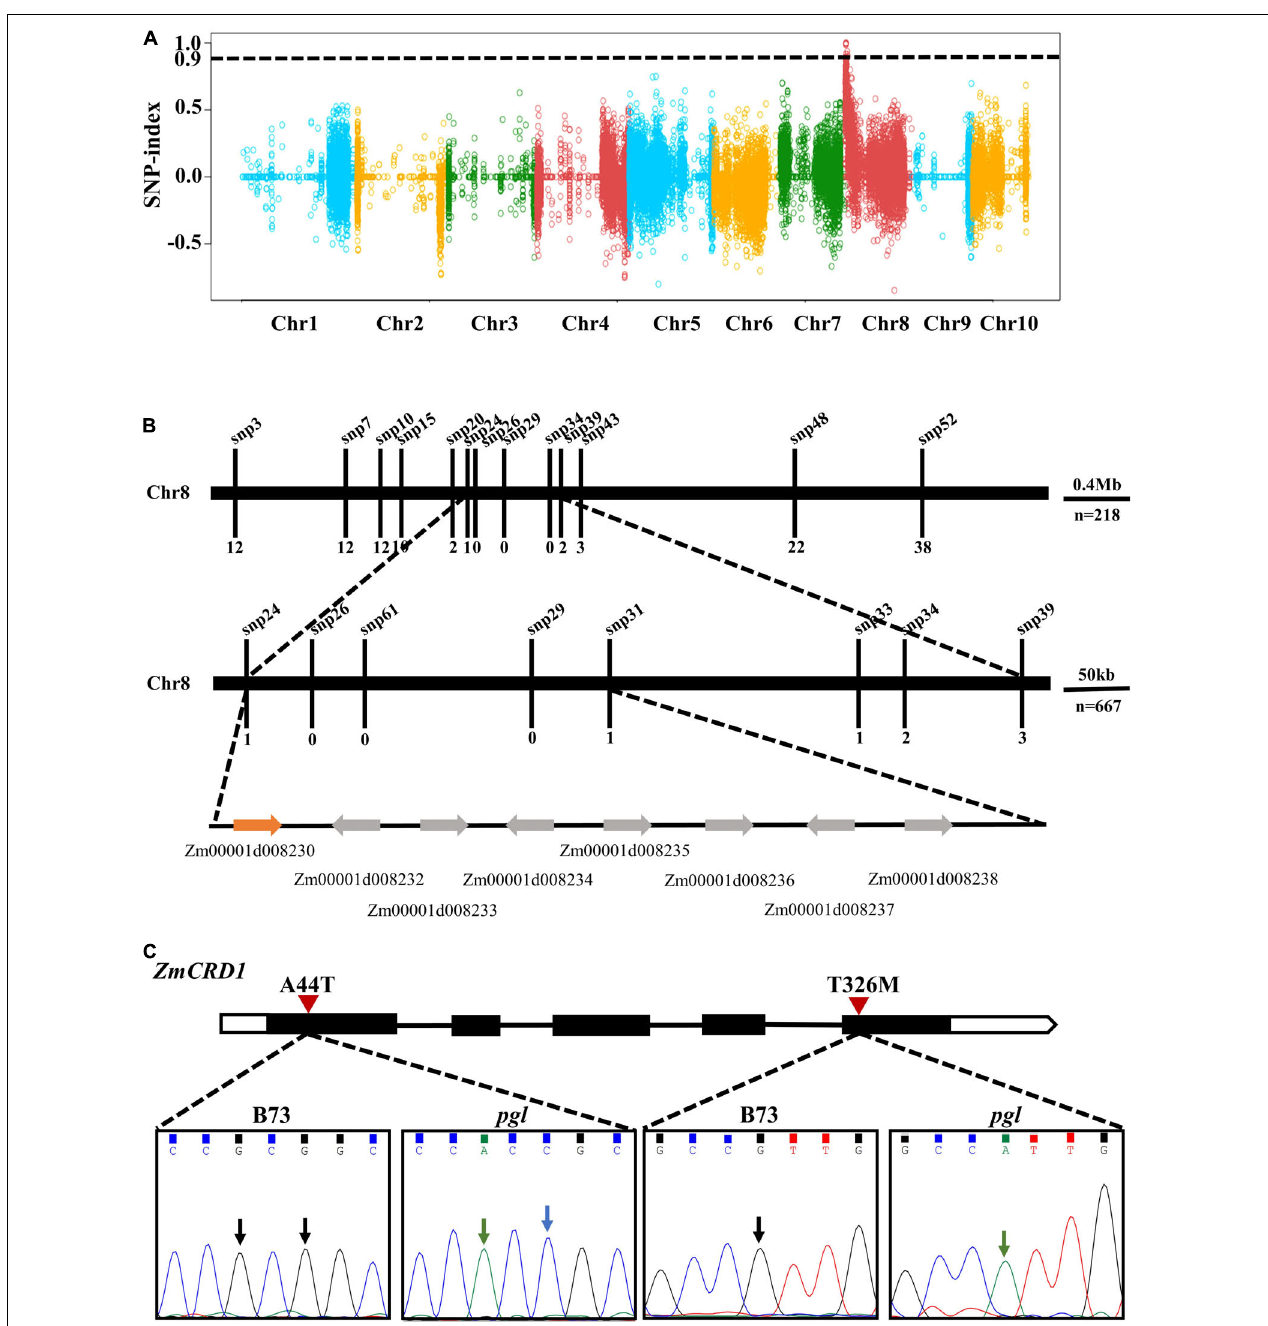
FIGURE 2 | Positional mapping of the PGL locus. (A) The PGL locus was initially mapped on chromosome 8 based on the BSA strategy and RNA-seq. The black dotted line is the threshold value (0.9). Dots of different colors belong to different chromosomes. (B) The PGL locus was finely mapped to a narrow interval of approximately 274 kb using HRM. (C) Gene model and mutation site analysis of the candidate gene ZmCRD1 . The black rectangles represent exons, lines represent introns, and the white regions represent UTRs. Arrows point to missense mutation sites between B73 and pgl .